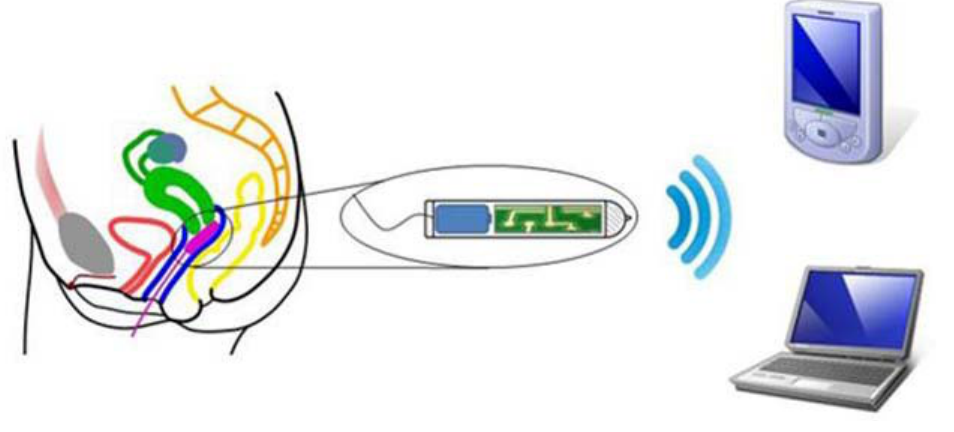
Figure 2. Illustration of the system